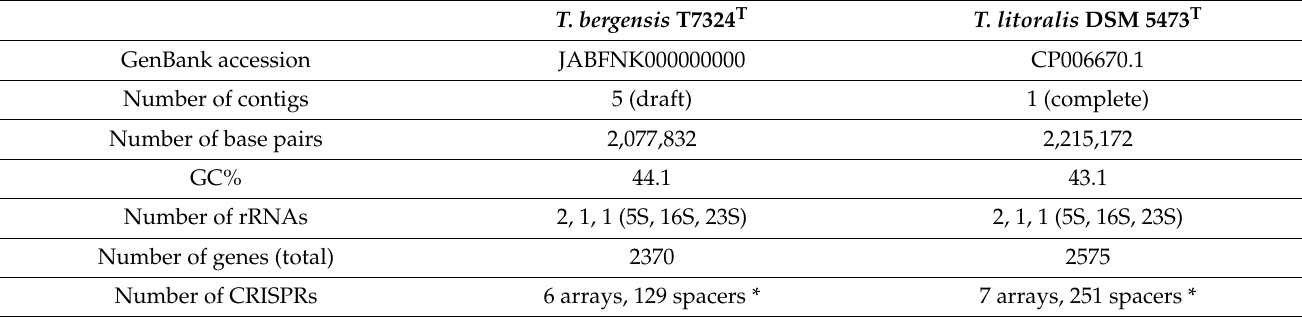
Table 1. Genome statistics of T. bergensis T7324 T and T. litoralis DSM 5473 T